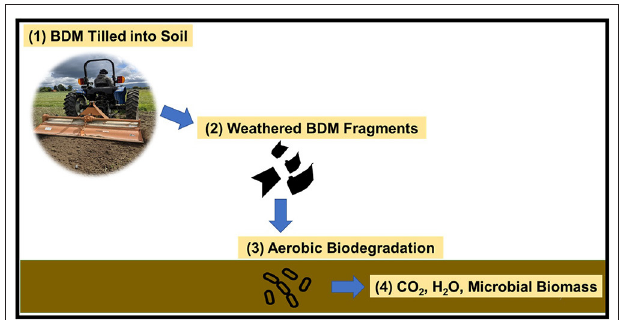
FIGURE 5 | Soil-biodegradable mulch degradation process after tillage (photo by Brenda